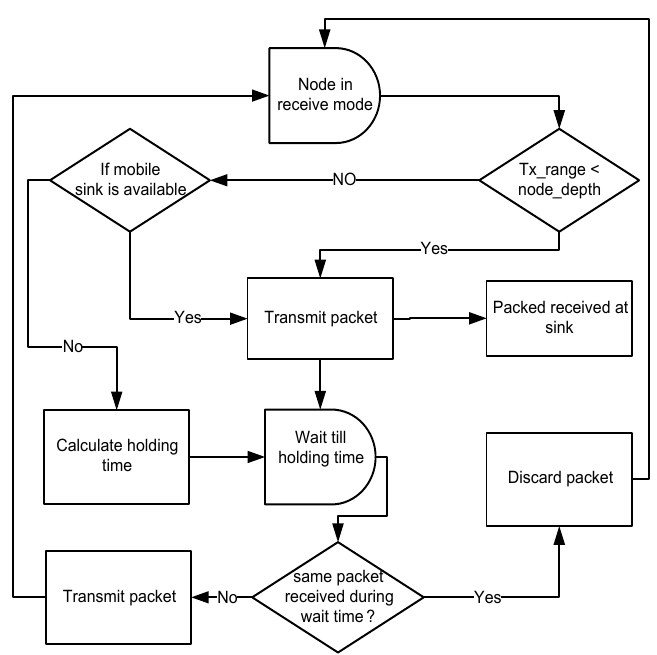
Figure 4. Hold and forward mechanism of packet-forwarding.